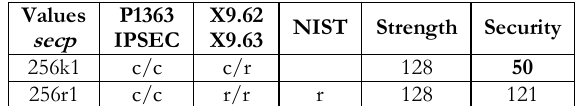
Table 1: Curve parameter security according to Montgomery Ladder